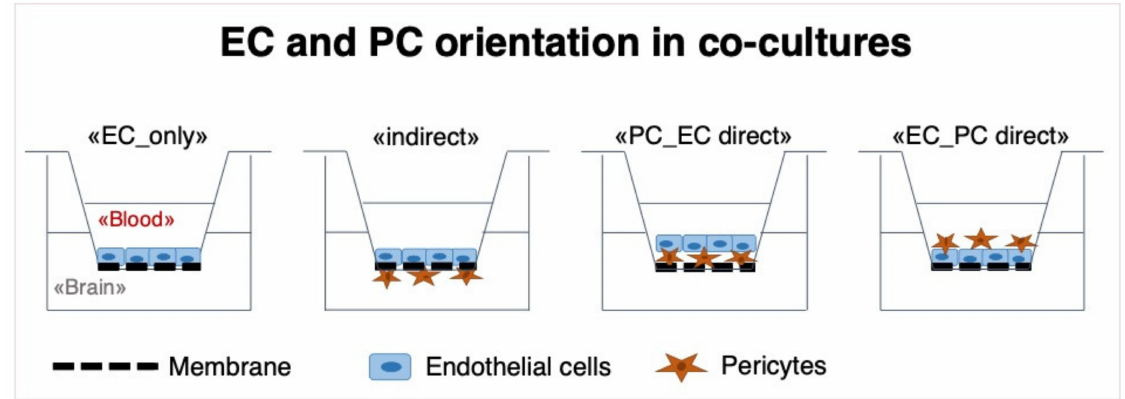
Figure 1. Schematic illustration of the experimental design of BBB models that were used in this study. “EC_only“: endothelial cells (ECs) are plated on the apical side of a 24-well-plate insert with a pore-size of 0.4 µ m. “indirect“: Pericytes (PCs) are plated on the basolateral side of the insert, and in a second step (after 3 h), ECs are plated on the apical side, allowing contact of the two cell types through the membrane. “PC_EC direct“: PCs are plated on the apical side of inserts first, and after 3 h, ECs are plated on top of PCs. “EC_PC direct“: ECs are plated first, and after 3 h, PCs are seeded on top of them.